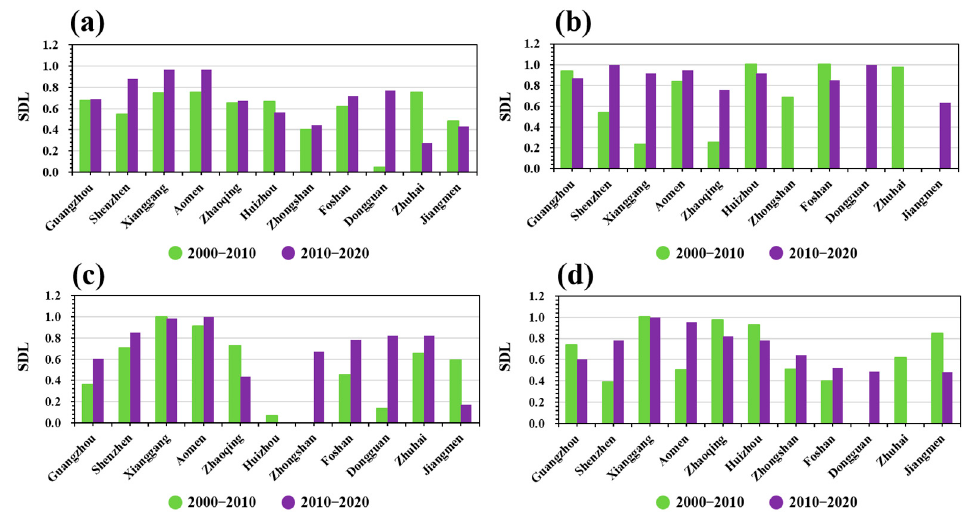
Figure 7. Changes in sustainable development level (SDL) of urban agglomeration in the GBA. ( a ) is overall space; ( b ) is production space; ( c ) is living space; ( d ) is ecological space.